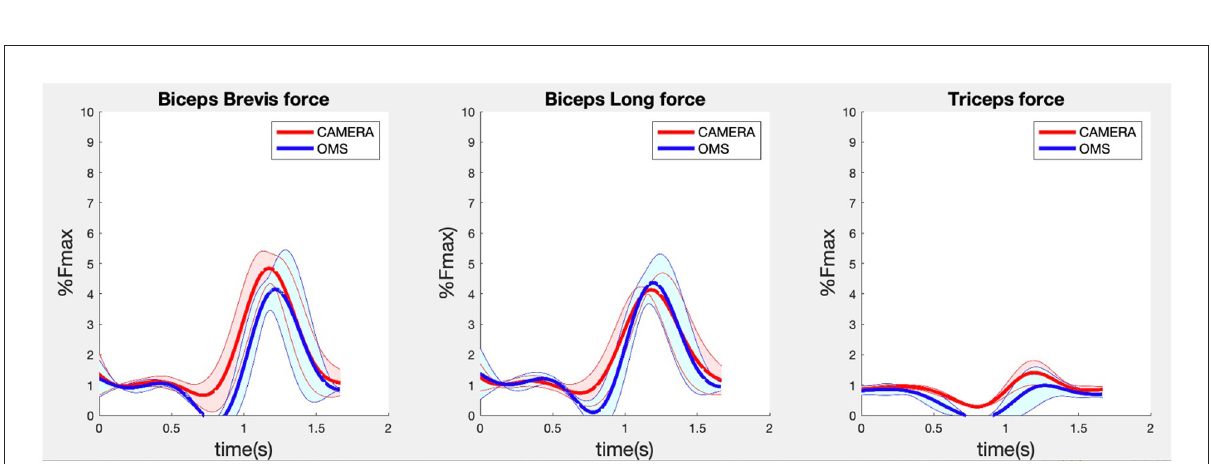
FIGURE7 Results for the biceps brevis (left), biceps long (middle) and triceps (right) muscle forces during the biceps curl exercise. Results obtained from OMS (blue) and camera (red) are presented as mean ± 1SD (shaded) over all